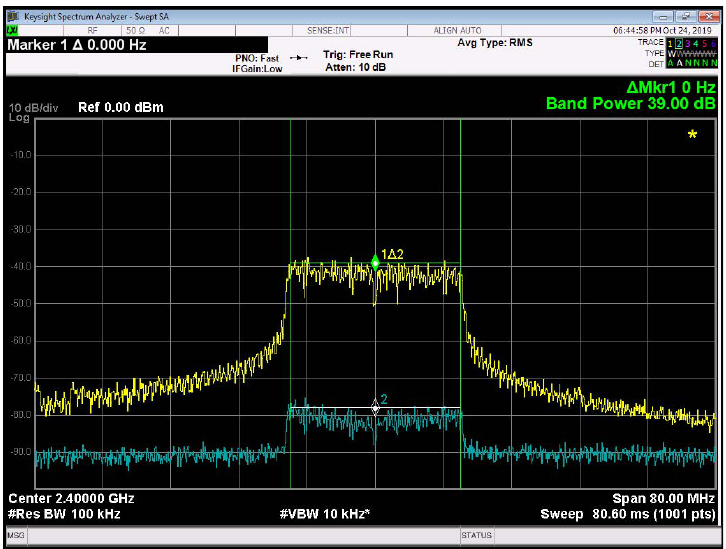
Figure 10. Cancellation performances with the OFDM